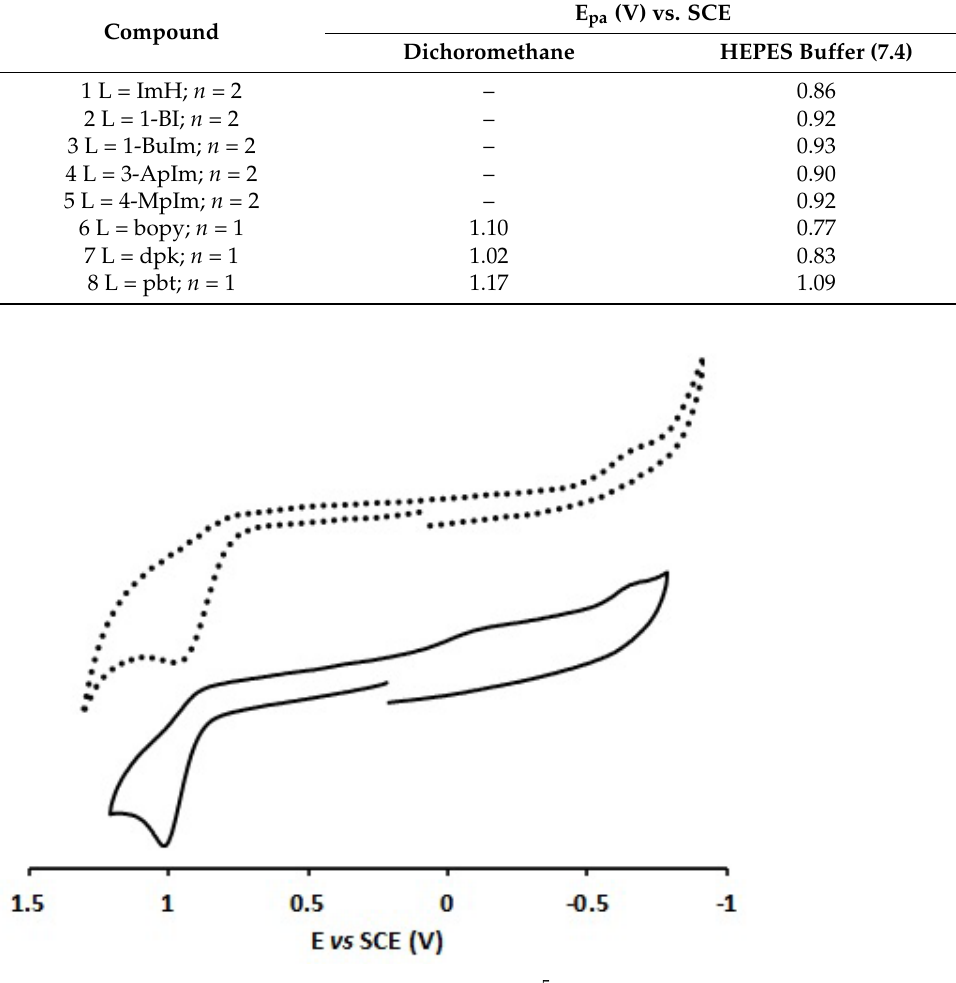
Table 2. Electrochemical data for complexes [Ru( η 5 -C 5 H 5 )(mTPPMSNa) n (L)] [CF 3 SO 3 ] ( n = 1,2) in dichloromethane and HEPES buffer. (SCE = saturated calomel electrode).